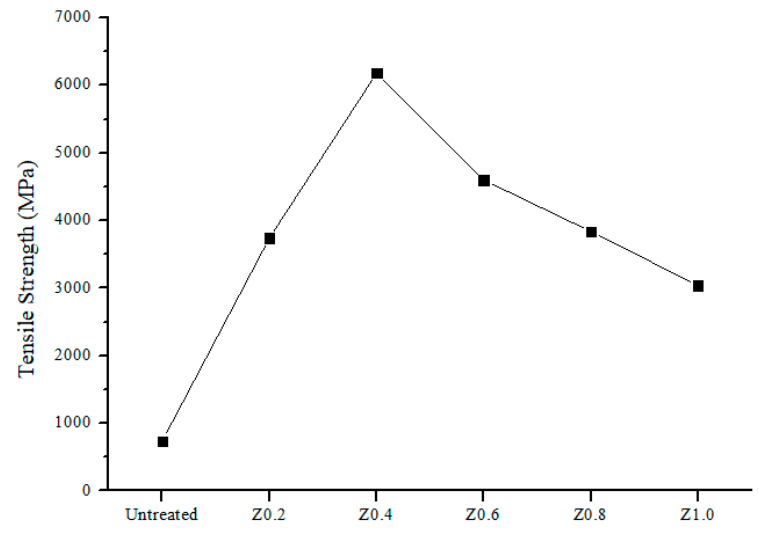
Figure 7. Tensile strength of untreated nylon 6,6 NFM and nylon 6,6/ZIF-8 NFM.